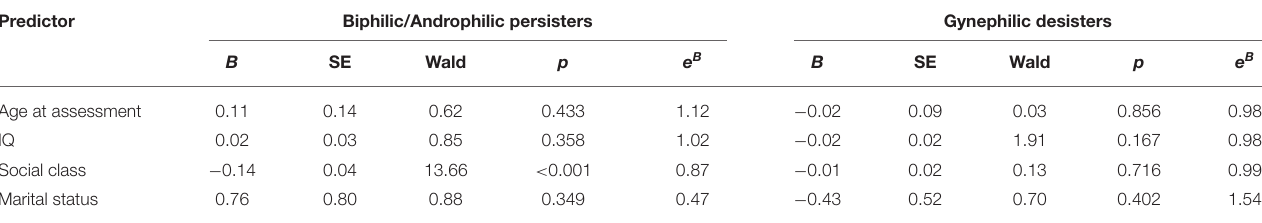
TABLE 4 | Multinomial logistic regression of group outcome at follow-up. Predictor